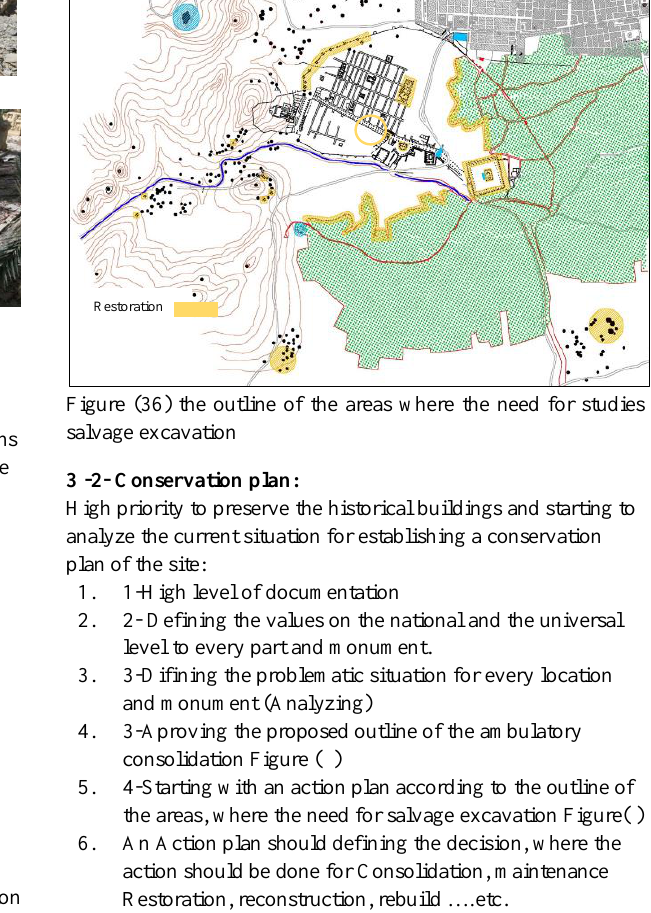
Fifure(30-31) the Castle